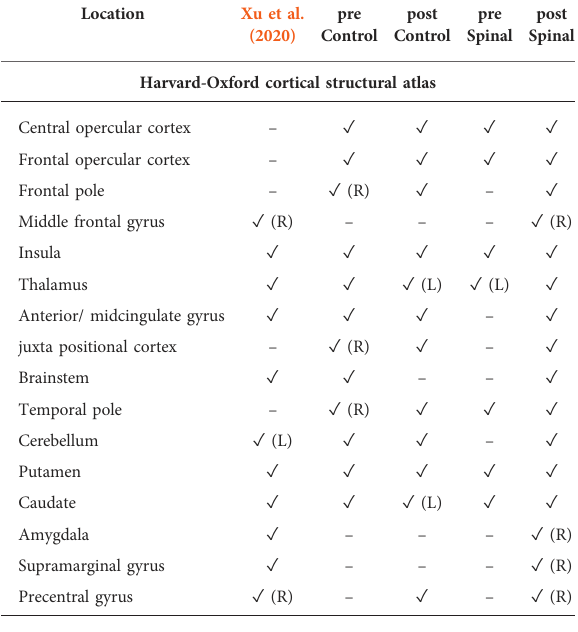
TABLE 2 Brain region activation and deactivation per session and time (pre, post). Deactivation were not part of the meta-analysis of Xu et al.